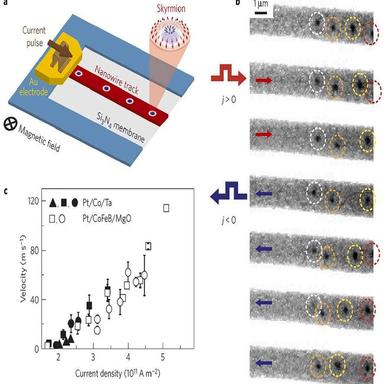
a) Schematic experimental setup for MTXM measurement of individual skyrmions injected into and moving along a racetrack. The nanowire track is deposited onto an X-ray transparent Si3N4 membrane, external fields are applied perpendicular to the membrane surface, and an Au electrode is used to launched current pulse into the track. b) Sequence of magnetic X-ray microscopy images showing a train of individual skyrmion as they are pushed by individual current pulses. c) Velocity of skyrmions as a function of cu